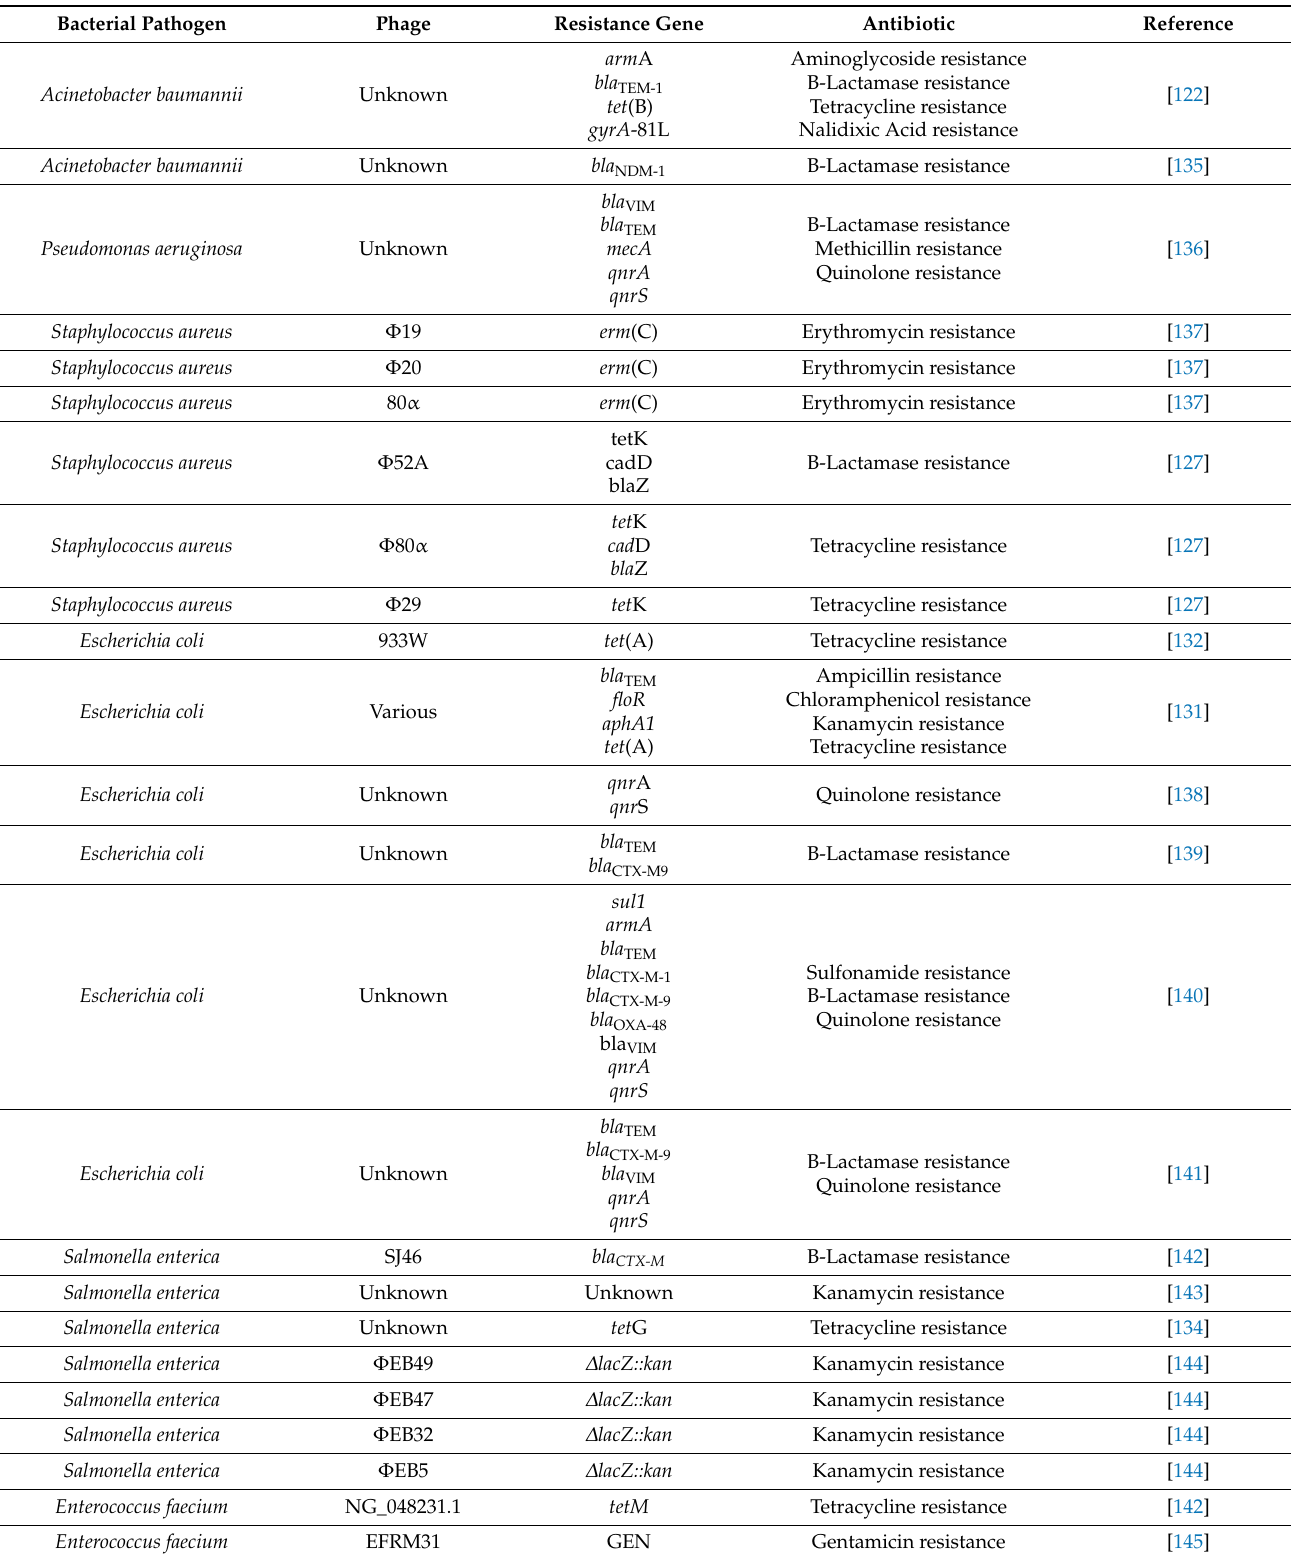
Table 1. Observed phage-mediated transduction events involving antibiotic resistance genes among bacterial pathogens identified as part of the World Health Organization’s Priority Pathogens since